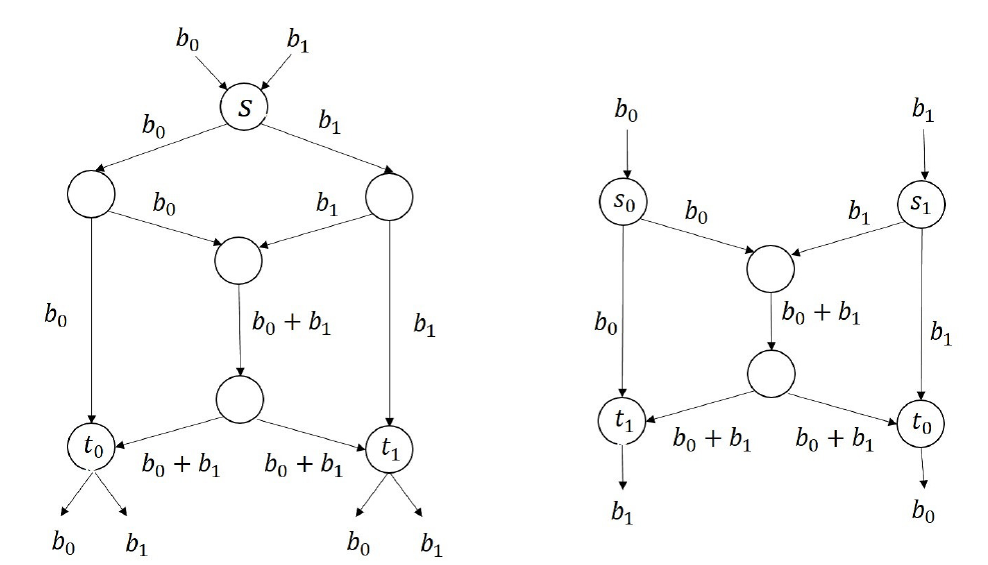
Figure 1. The left-hand side is a multicast classical network coding on the butterfly network, where a single source node s sends messages b 0 and b 1 on the finite field F q : = Z / Z q to both target nodes t 1 and t 2 , where q is a prime power. The right-hand side is a multiple-unicast classical network coding on the butterfly network, where a source node s 0 sends message b 0 ∈ F q to target node t 0 , and source node s 1 sends message b 1 ∈ F q to target node t 1